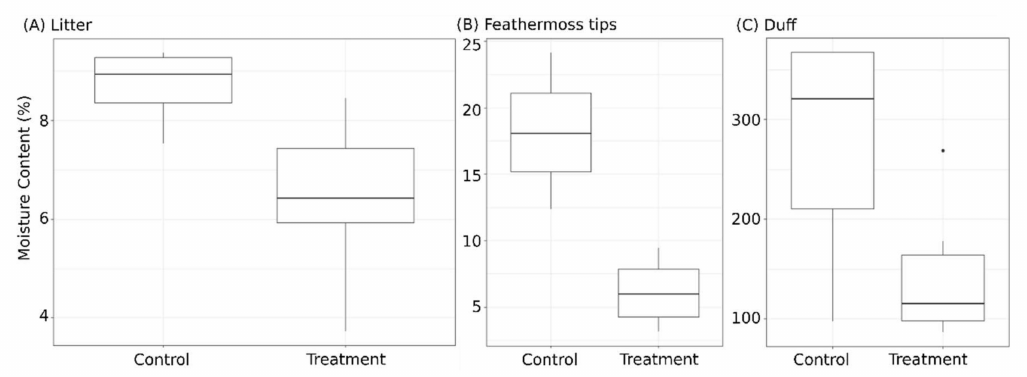
Figure 3. Observed fuel moisture content (% water by dry weight) for surface litter ( A ), moss tips ( B ), and du ff ( C ) greater than approximately 6 cm from the